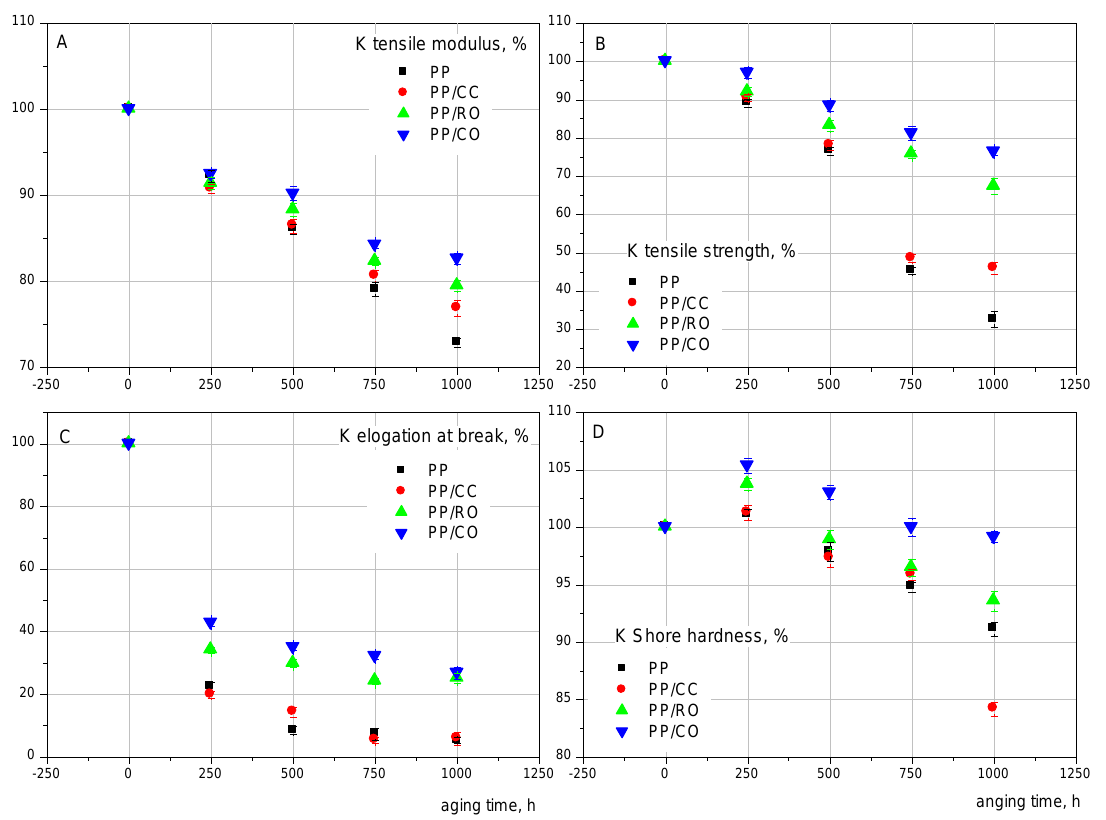
Figure 2. The changes in mechanical properties of iPP and its composites after accelerated aging (K coefficients): ( A )—Young’s modulus; ( B )—tensile strength; ( C )—elongation at break; ( D )—Shore hardness (D scale).